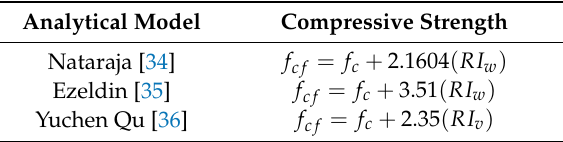
Analytical models for predicting the compressive strength of steel fiber reinforced concrete (SFRC).